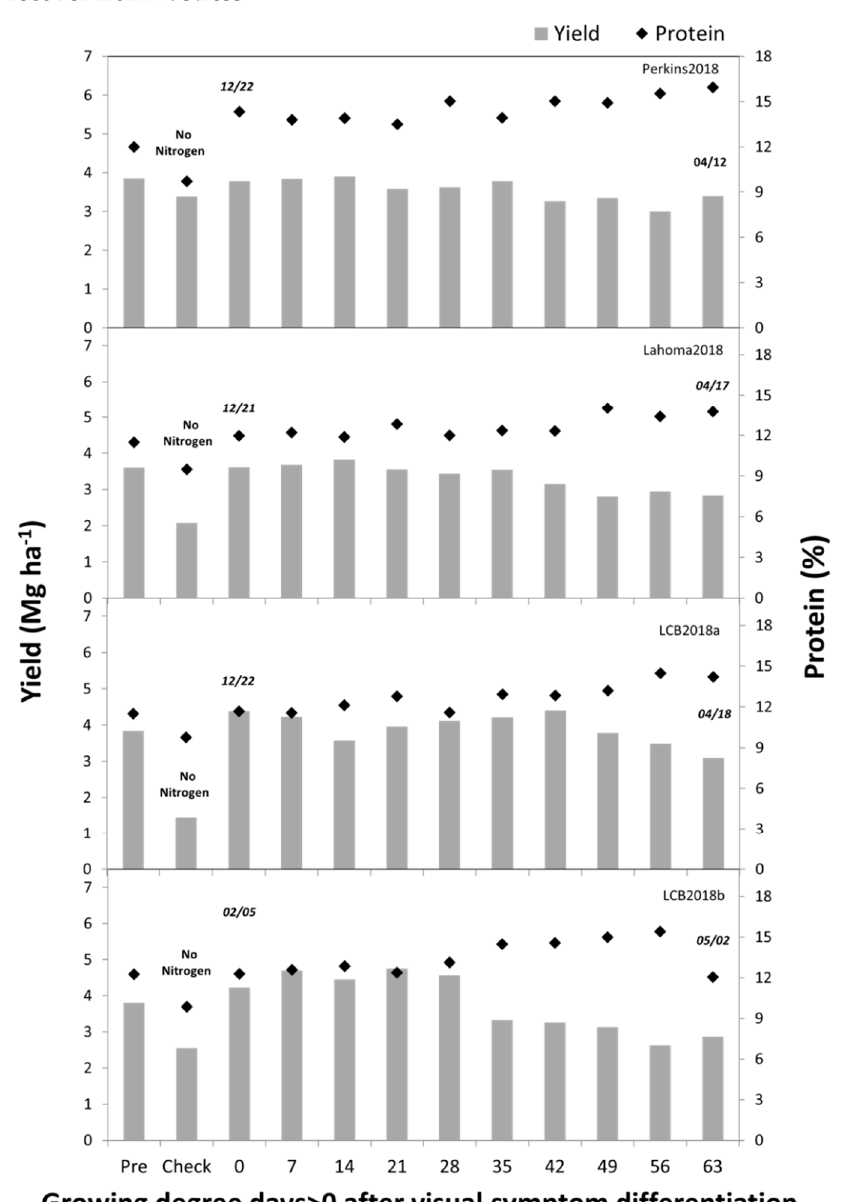
Figure 2. Winter wheat grain yield and protein response to the application of 100 kg N ha − 1 as affected by the timing of application at Perkins, Lahoma, Lake Carl Blackwell (a), and Lake Carl Blackwell (b) at Oklahoma in 2017–2018. The “a” and “b” demonstrates two different studies in the same year on the same location (LCB2017a and LCB2017b) .